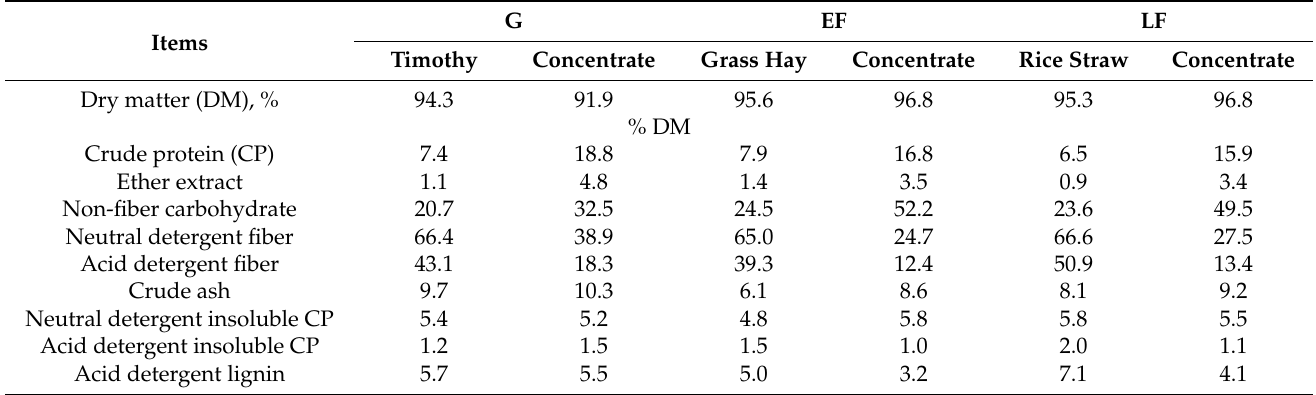
Table 1. Chemical composition of experimental